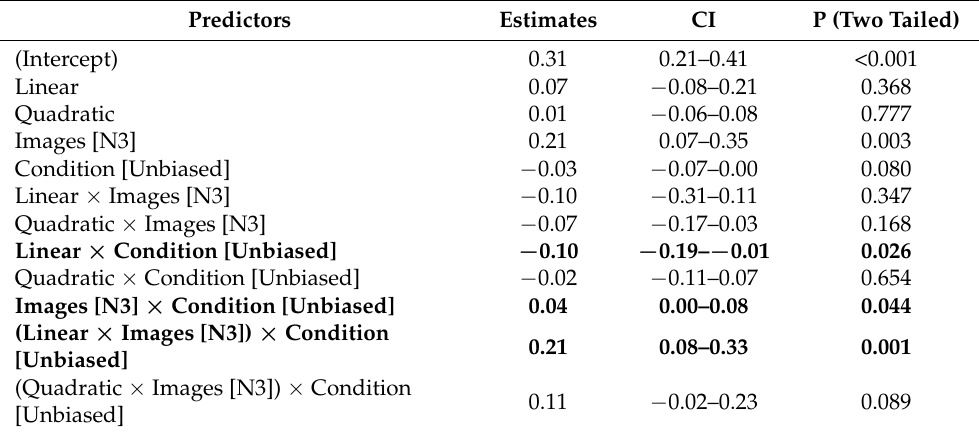
Table 8. Results of GCA analysis of AMC data for time window 4 (processing N2 relative to N3).